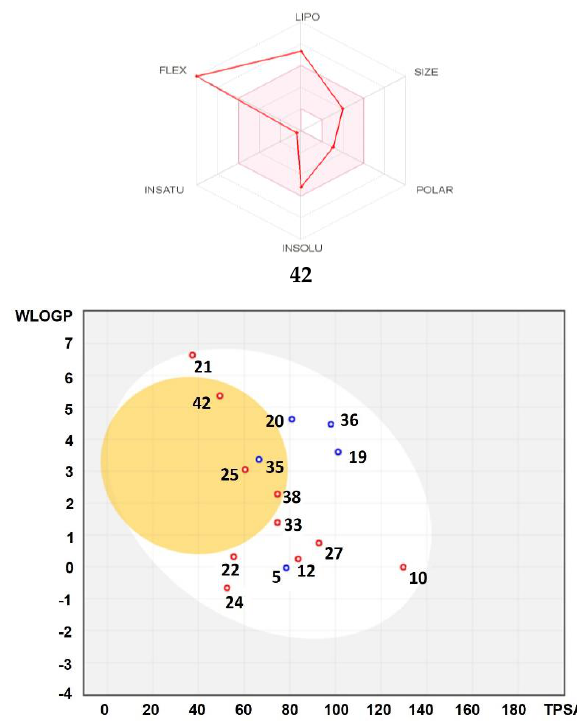
Figure 2. Bioavailability radar of identified compounds based on physicochemical indices ideal for oral bioavailability. LIPO, Lipophilicity: − 0.7 < XLOGP3 < þ 5; SIZE, Molecular size: 150 g / mol < mol. wt. < 500 g / mol; POLAR, Polarity: 20 Å2 < TPSA < 130 Å2; INSOLU, Insolubility: 0 < Log S (ESOL) < 6; INSATU, Insaturation: 0.25 < Fraction Csp3 < 1; FLEX, Flexibility: 0 < Number of rotatable bonds < 9. The colored zone is the suitable physicochemical space for oral bioavailability (Top). Boiled-egg model of identified compounds (Bottom). ESOL: Estimating Aqueous Solubility from Molecular Structure, TPSA: topological polar surface